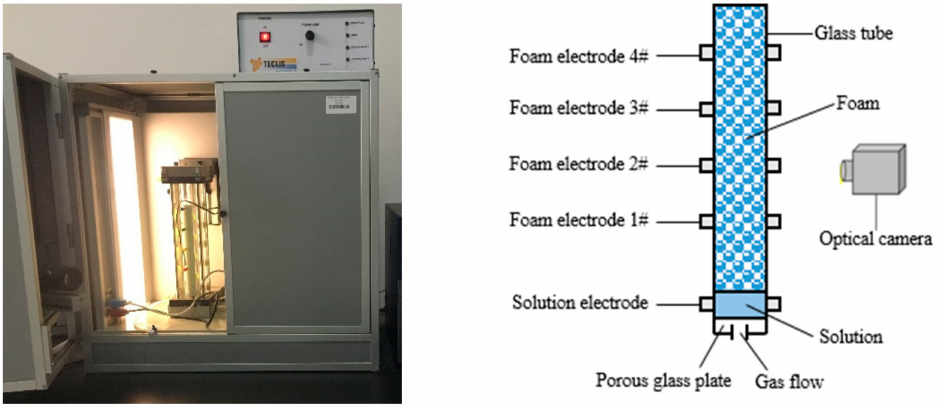
Figure 1. Foamscan